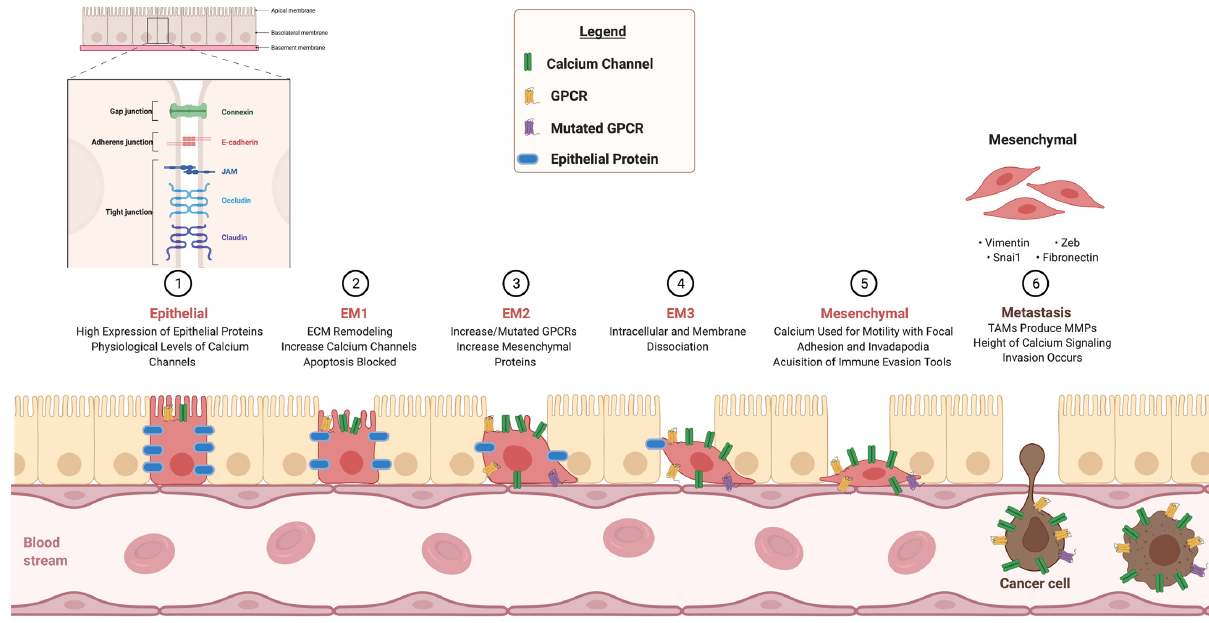
Figure 3. Calcium alterations causative of EMT. This schematic illustrates the role of calcium signaling, which is required for progression from a normal epithelial cell to an EMT phenotype associated with metastatic cancer cells, by showing (1) The starting point of a healthy epithelial cell containing all tight junction proteins and physiological levels of GPCRs and calcium channels. (2) Gradual reduction in junction proteins and increased calcium channel production. (3) Gradual increase in mesenchymal proteins, such as Vimentin and N-Cadherin, and GPCRs acquiring mutations. (4) ECM dissociation through integrins. (5) Increased motility. (6) Invasion of a cancer cell into bloodstream, to metastasize away from primary tumor. Junctional adhesion molecule (JAM); Zinc finger E-box-binding-homeobox (ZEB).